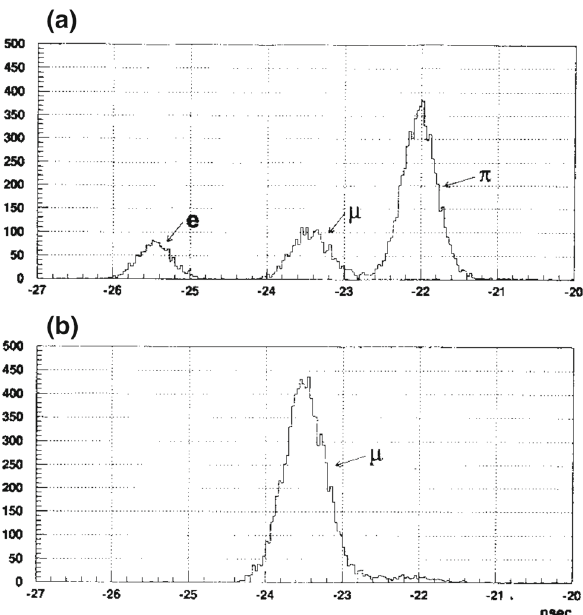
Fig. 3 Charged particle ID in the beam line by TOF at 500 MeV/c before the second bending magnet ( a ) and after ( b )